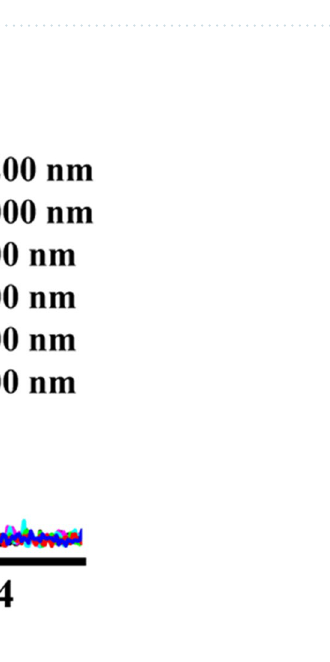
Figure 5. Sample A: ( a ) Gaussian fit for RT PL measurements, and ( b ) full-width-half-maxima and Gaussian energy peaks versus pitch.